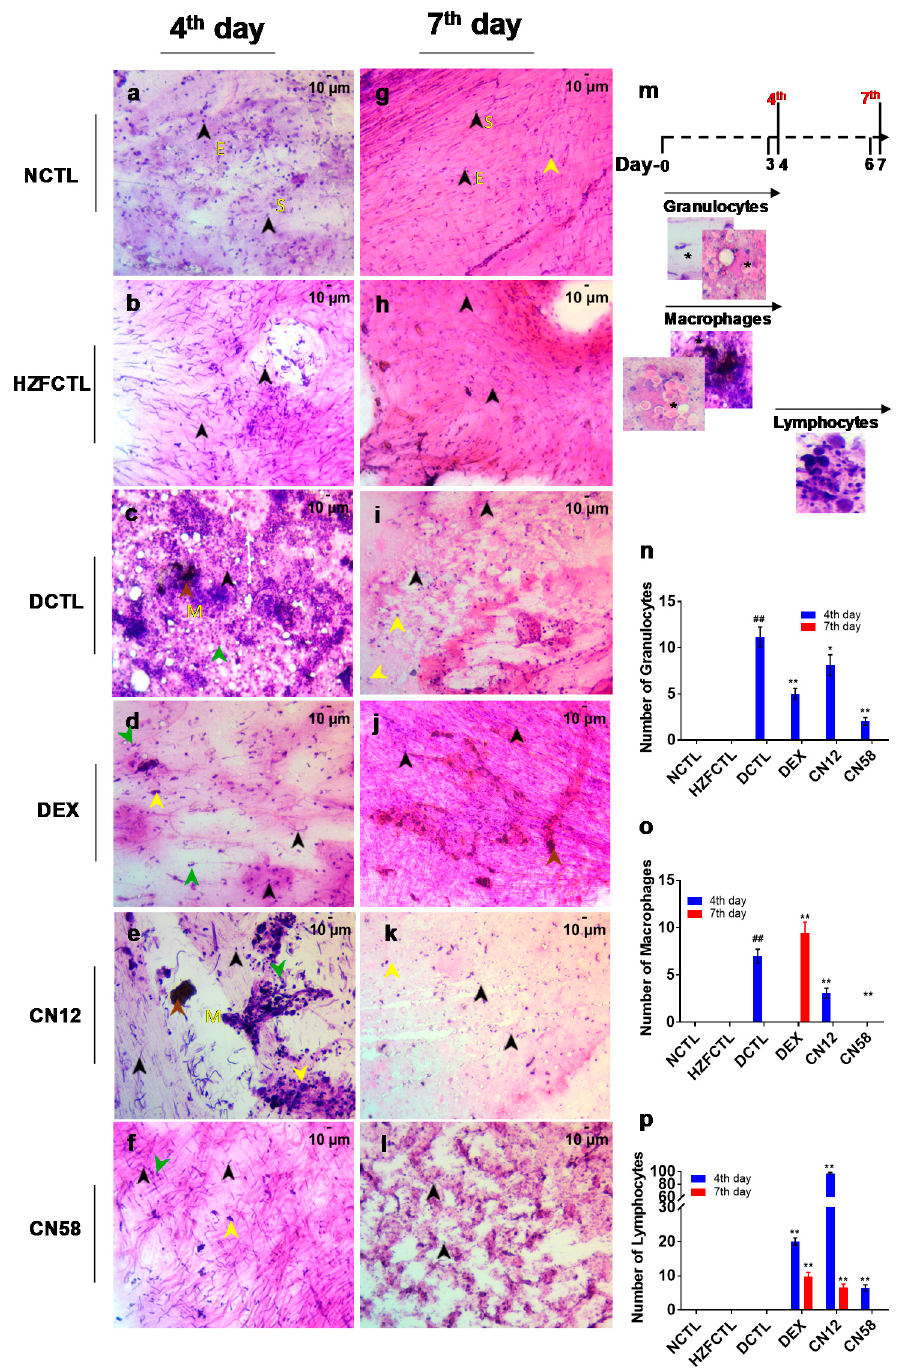
Figure 5. Coronil rescues from SARS-CoV-2 spike protein induced inflammation in swim bladder cytosmears. Cytosmears of the swim bladder were analyzed for inflammatory cell accumulation based on cell and nuclear morphology. Representative images of Hematoxylin and Eosin (H&E) stained swim bladder cytosmears of ( a ) NCTL at 4th day and ( g ) NCTL at 7th day and HZFCTL at 4th day ( b ) and at 7th day ( h ) showed cells with normal morphological characteristics. ( c , i ) DCTL showed infiltration of granulocytes and macrophages and cellular materials and nuclear debris and edema. ( d , j ) DEX treatment rescued from inflammation along with the presence of cellular debris. ( e ) Coronil (12 µ g / kg) at 4th day, ( f ) Coronil (58 µ g / kg) at 4th day; ( k ) Coronil (12 µ g / kg at 7th day, and ( l ) Coronil (58 µ g / kg